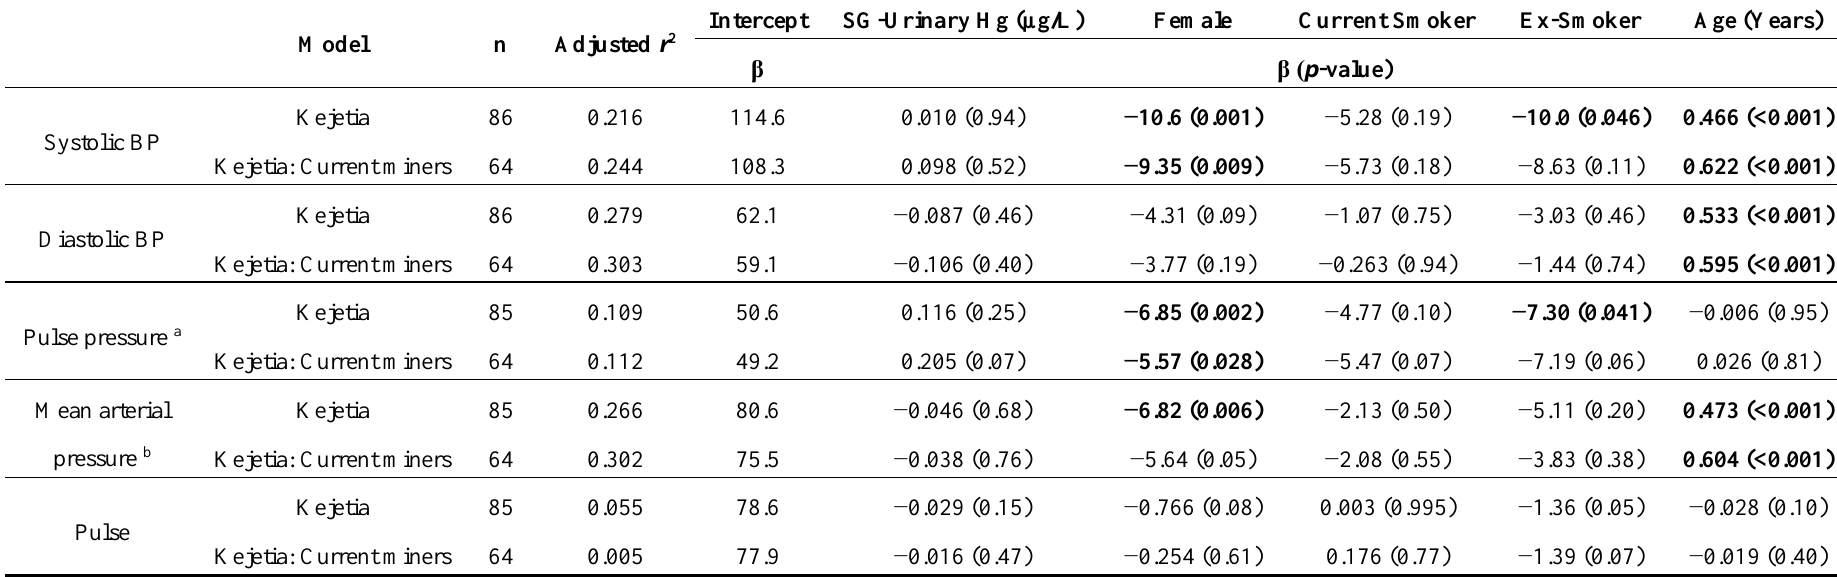
Table 5. Results of linear regression models for BP measures and specific gravity-adjusted urinary Hg concentrations. Each line represents a separate model. Analyses excluded participants with emergency high BP statuses (n = 4) and urinary Hg concentrations < 45 µg/L (n = 3). Statistically significant results are in bold